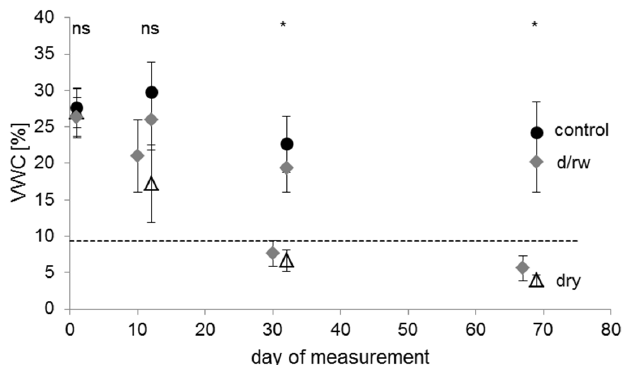
Figure 2. Mean values of soil volumetric water content (VWC) at different points in time of the experiment for plants of the control (filled circles, n = 144 measurements with 36 plants), the drying/rewetting (d/rw; grey diamonds, n = 241 measurements with 36 plants), and the dry (empty triangles, n = 119 measurements with 36 plants) treatment groups. Error bars indicate standard deviation. The dashed horizontal line represents the permanent wilting point (9.4% VWC at pF 4.2) of the soil. Asterisks indicate significant differences between the irrigation regimes ( p < 0.05); ‘ns’ indicates no significant difference. Day 1 was the 25 June 2012.